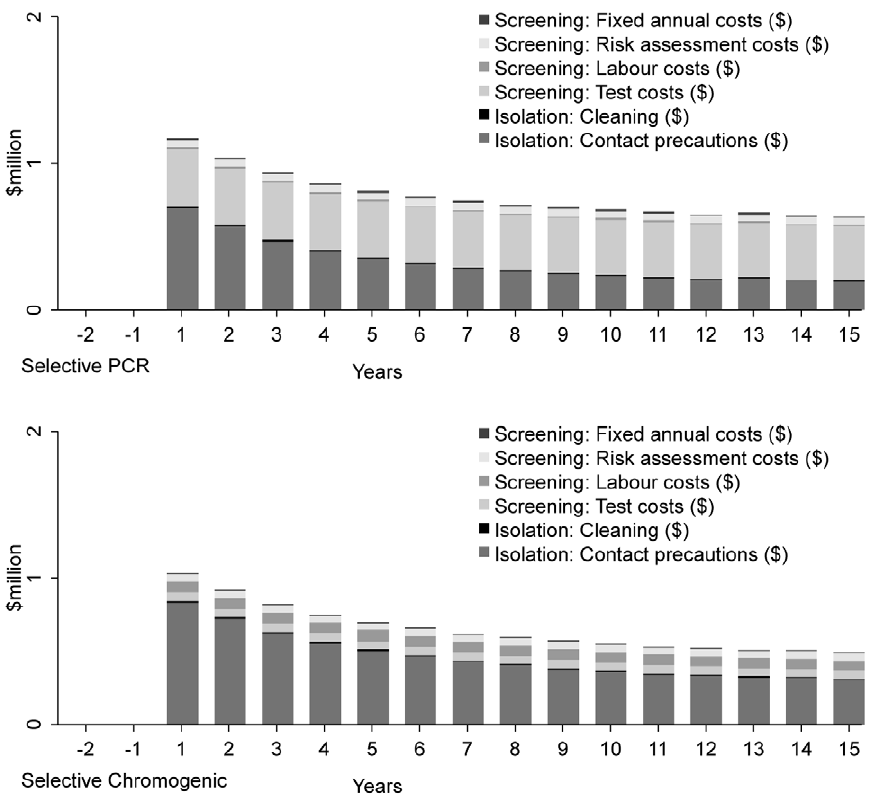
Figure 2. Annual cost of screening and isolation, and rate of infection. The annual undiscounted cost in US $ (2007) of strategies ‘Selective PCR’ (left) and ‘Selective Chromogenic’ (right) in a high prevalence setting. The first two years represent baseline (no screening and no isolation).